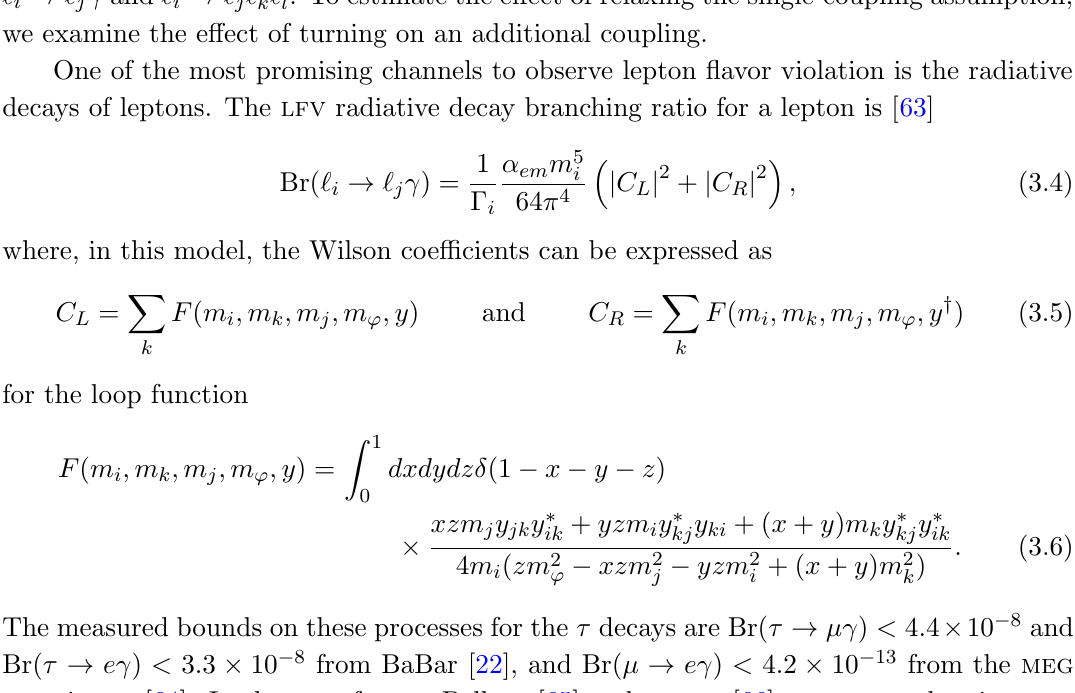
Figure 1 . Constraints on the coupling decays. Right: lfv constraints from (cid:22)